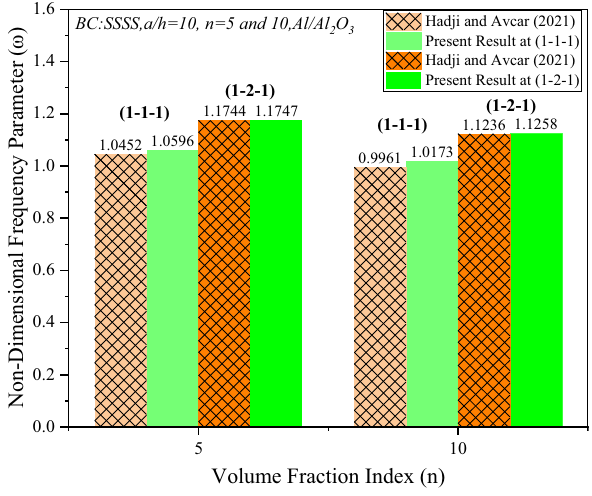
Figure 6: Validation of NDFP for two plate con fi gurations of SFGM square plate under the SSSS boundary condition using Al/Al 2 O 3 .